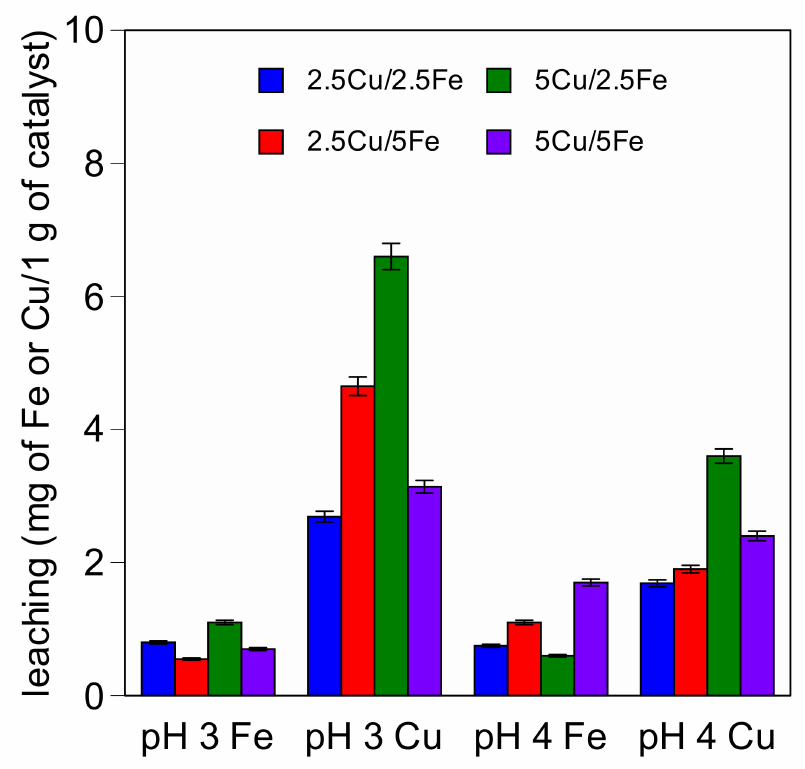
Figure 5. Iron and copper leaching at pH 3 and 4 (reaction conditions: catalyst dose—200 mg/L, H 2 O 2 dose—30 mL/L, temperature—70 ◦